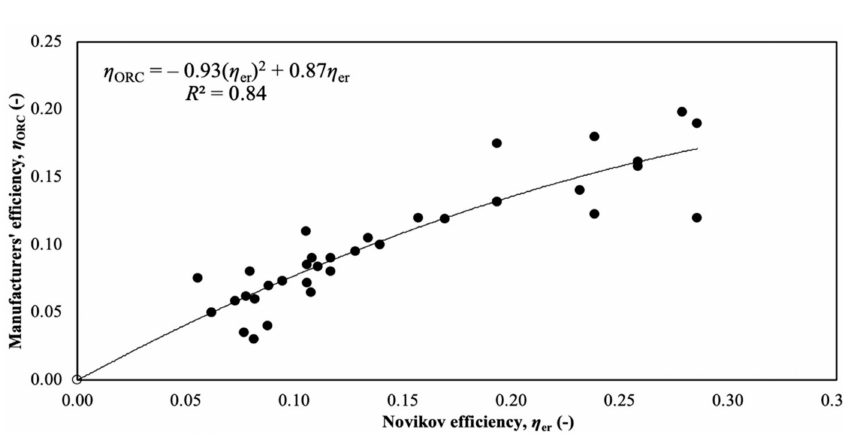
Figure 4. Thermal e ffi ciencies of 34 commercial ORC engines from manufacturer datasheets as a function of their corresponding Novikov e ffi ciency. The range of Novikov e ffi ciencies corresponds to heat-source temperatures up to 330 ◦ C (based on a heat-sink temperature of 25 ◦